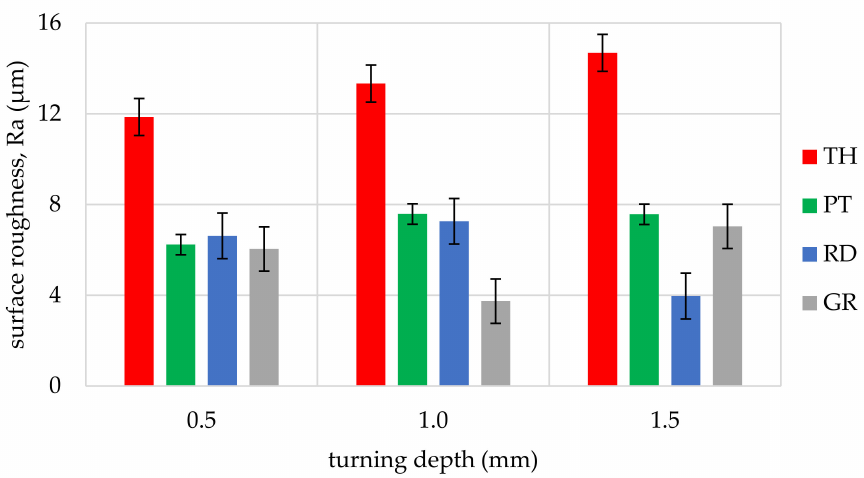
Figure 10. Influence of turning depth and type of cutting insert on surface roughness of Oakwood, Quercus robur